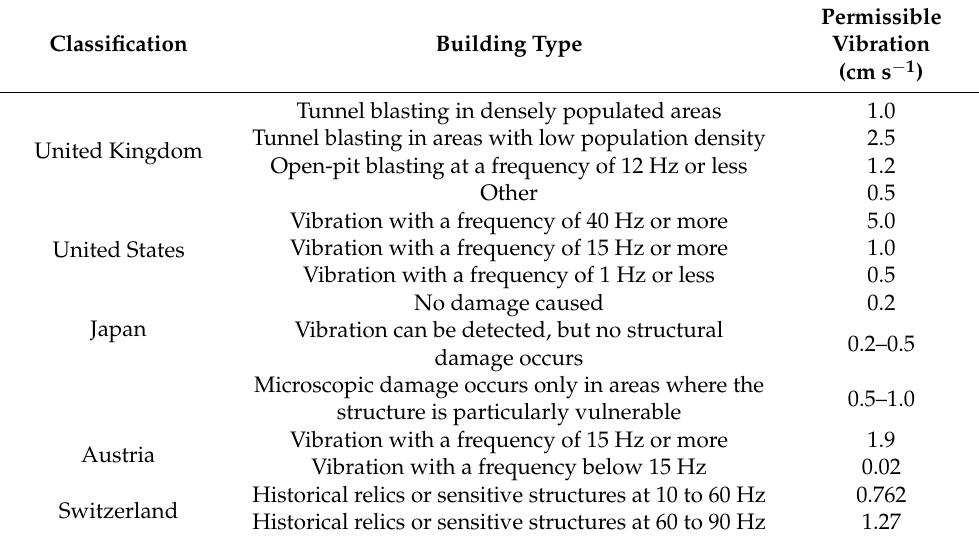
Table 4. Overseas blasting vibration standards [15].